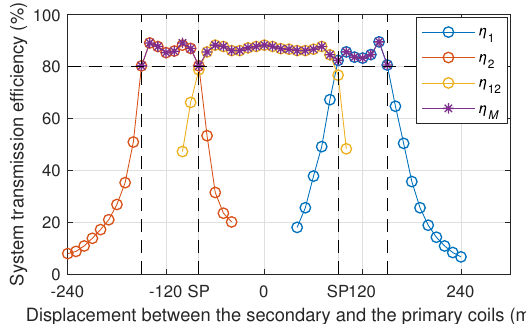
Figure 11. Two-to-one WPT prototype transmission